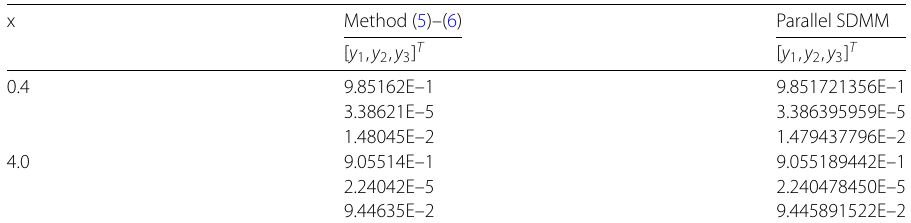
Table 1 Numerical results for Test 1